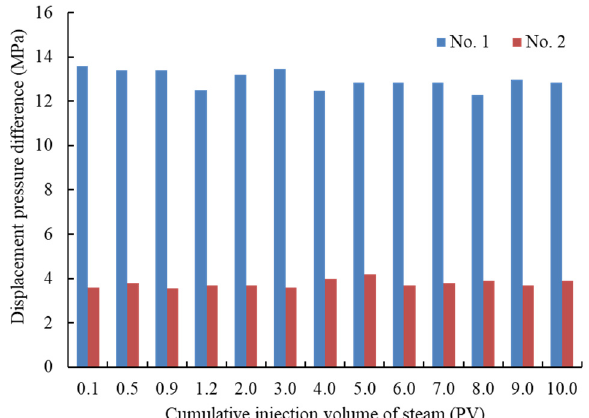
Figure 9. Changes in the displacement differential pressure.